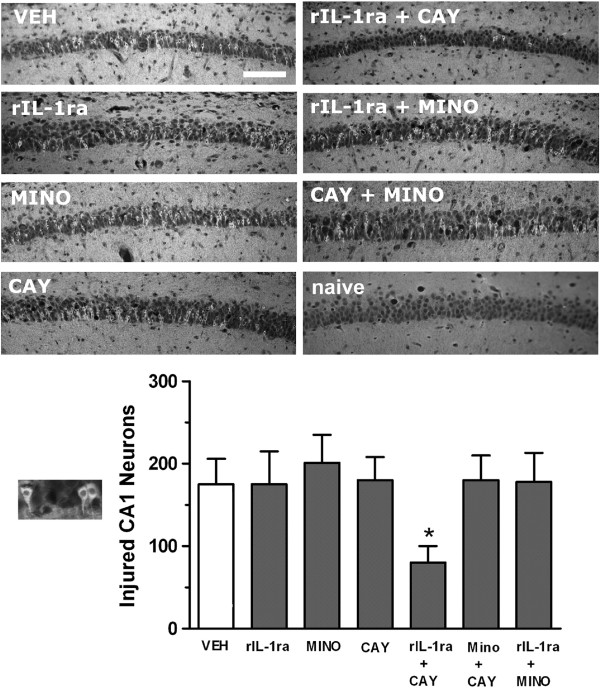
Neuronal injury in hippocampal CA1 subfield after co-administration of anti-inflammatory drugs against LPS + pilocarpine-induced SE in 2-week-old rats. Treatment with a single anti-inflammatory compound did not diminish the amount of CA1 hippocampal damage as compared to vehicle (left column). A combination treatment of rIL-1ra + CAY resulted in significant reduction of injured neurons which was not seen with any other combination (right column). Outset shows high magnification of eosinophilic neurons with pyknotic nuclei and irregular cell bodies that were counted as injured CA1 cells in the graph. Bars represent mean ± SEM. Quantification shows significant attenuation of neuronal injury resulted from combined administration of rIL-1ra + CAY administered prior to the onset of status (*P <0.05). CAY, COX-2 inhibitor (10 mg/kg); MINO, minocycline; naïve, age-matched normal rat (no seizures, no treatment); rIL-1ra, recombinant interleukin-1 receptor antagonist; VEH, vehicle. Scale bar is 50 μm.